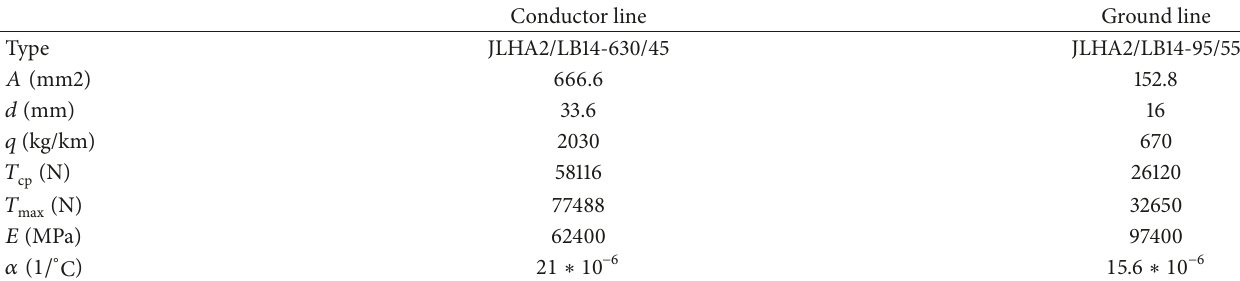
Table 1: Types and parameters of